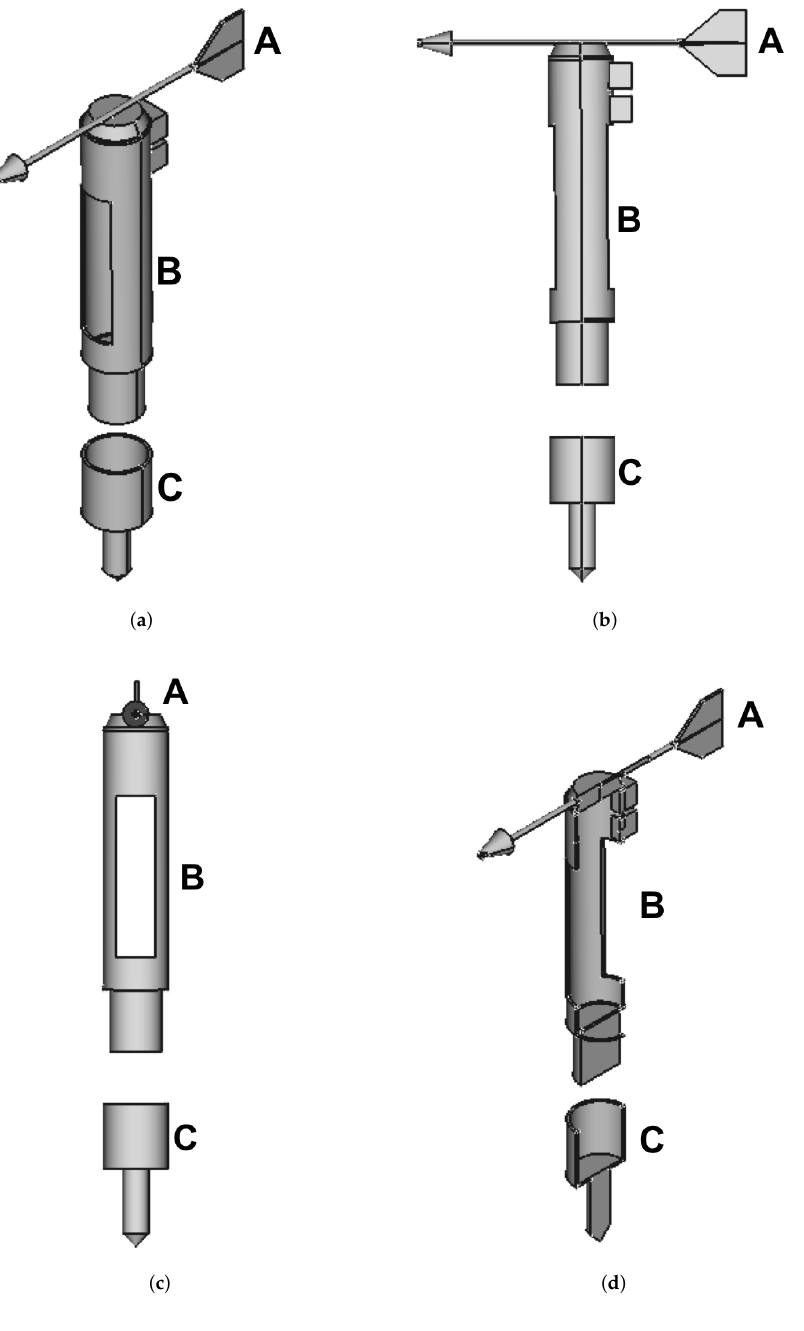
Figure 1. 3D model of the mechanical structure: ( a ) axonometric view, ( b ) lateral view, ( c ) frontal view and ( d ) axonometric section. Starting from the top of each subfigure: the weather vane (A), the rotating part with the front opening to let the sand enter (B), the fixed base that will be placed under the beach level